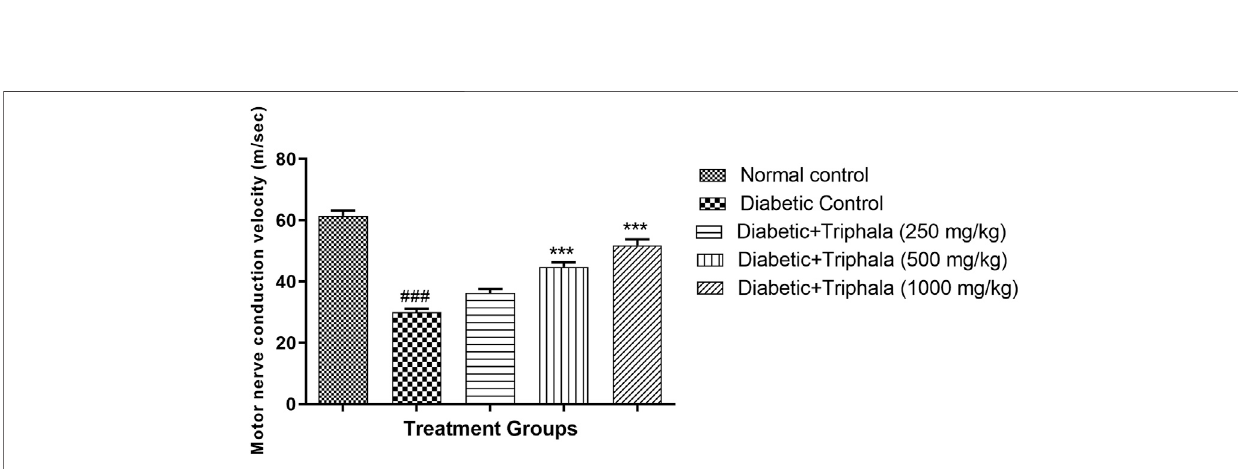
Frontiers in Pharmacology |